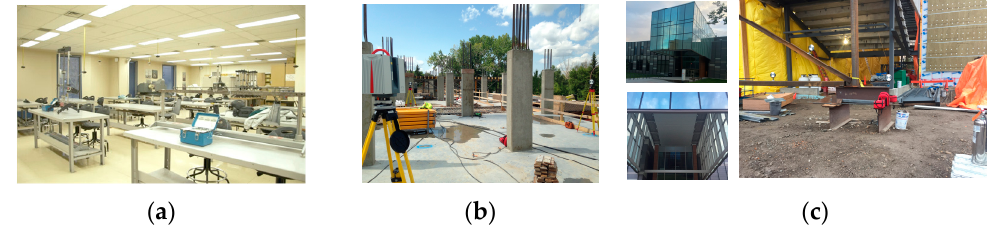
Figure 7. ( a ) MML laboratory; ( b ) GSHR construction site; and ( c ) TITL building.